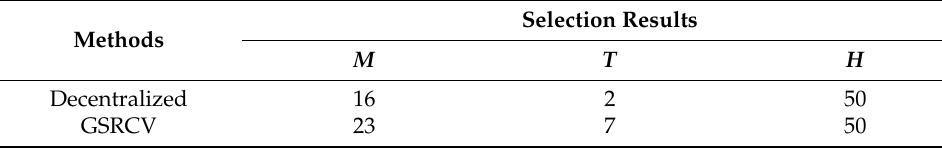
Table 3. Parameter selection results of different optimization methods.